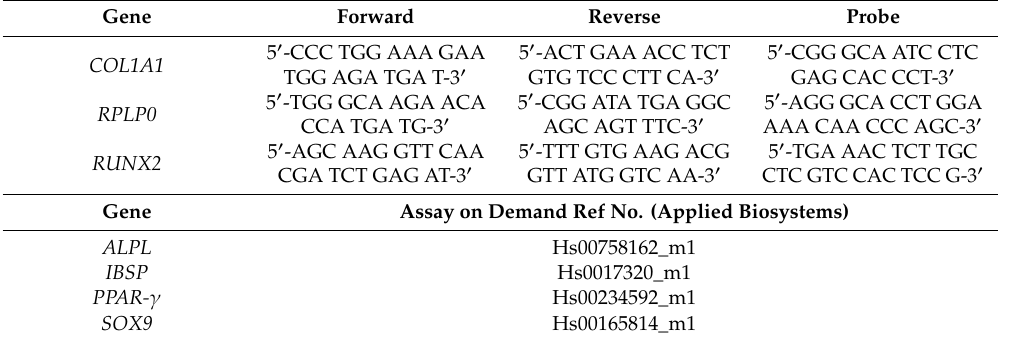
Table 2. Primers / probes used for